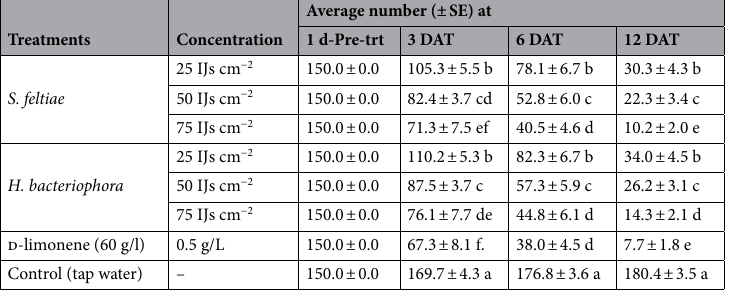
Table 5. Average number of Dactylopius opuntiae nymphs alive at 1-day pre-treatment and 3, 6, and 12 days after been exposed to S. feltiae , H. bacteriophora , and d-limonene (60 g/l) (DAT), or tap water under field conditions. In each column, averaged means within followed by the same letters are not significantly different according to Tukey’s LSD test at α = 0.05.